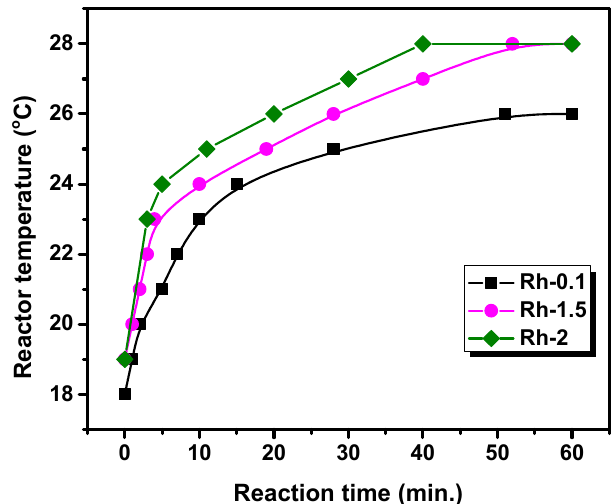
Figure 7. The change in the reactor’s temperature during the hydrogenation of cyclohexene over Rh-TUD-1 samples as a function of the reaction time.